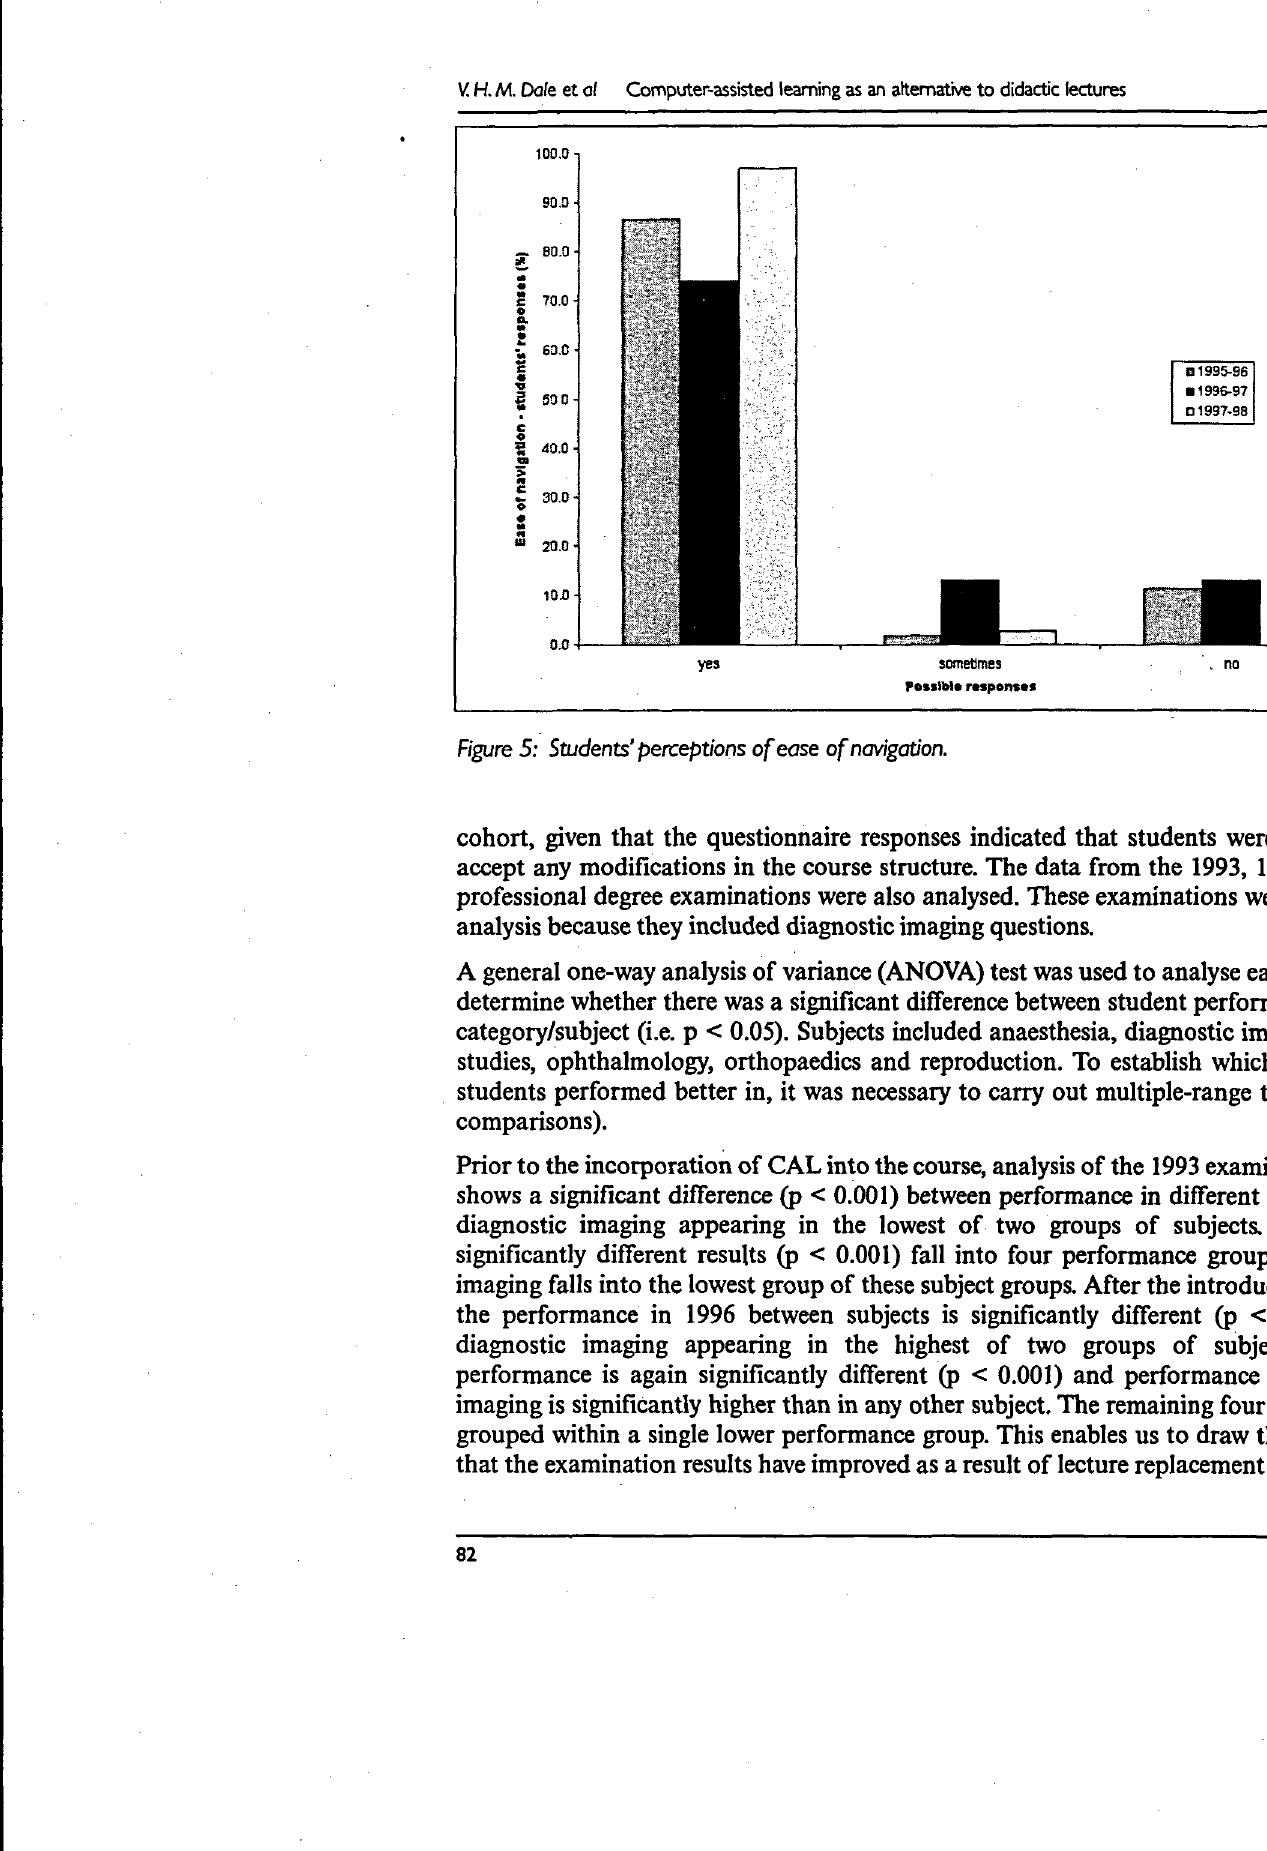
Figure 5: Students'perceptions of ease of